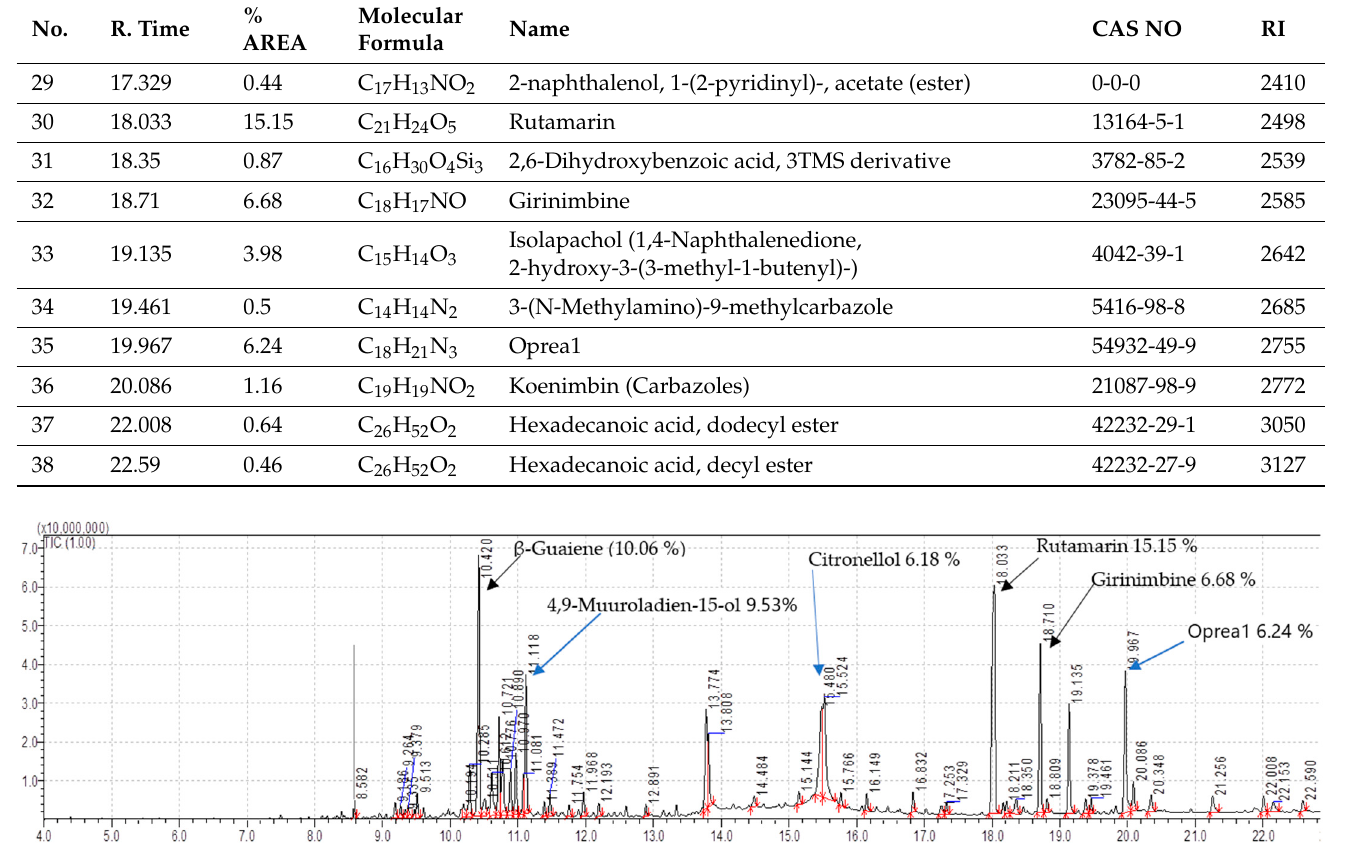
Figure 6. GC-MS/MS Chromatogram of isolated non-volatile oil C of root bark of T. ciliata. Table 12. Phytocompounds identified in isolated non-volatile oil C from the root bark of T. Ciliata Compounds were identified and reported for the first time in non-volatile oils (NVO) by GC-MS/MS. of the genus Toona.